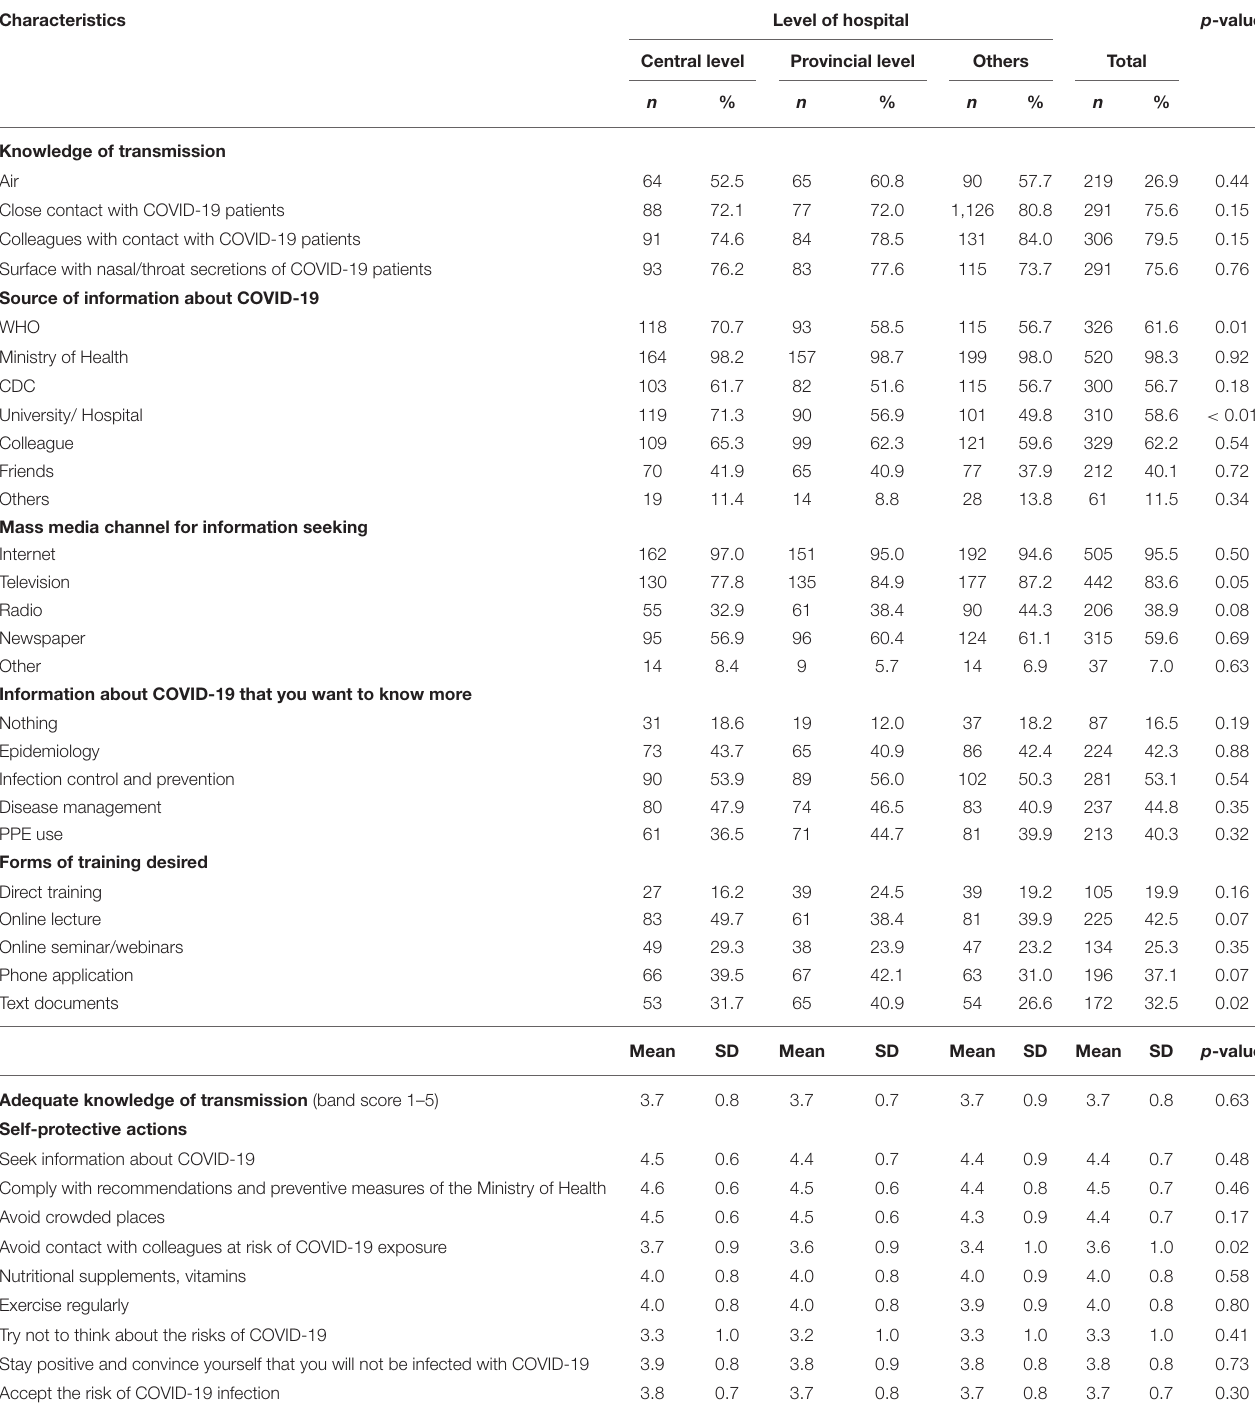
TABLE 2 | Knowledge, sources of information, preferences for training platform, and practice on the transmission and self-prevention against the coronavirus disease 2019 (COVID-19). Characteristics Level of hospital p -value Central level Provincial